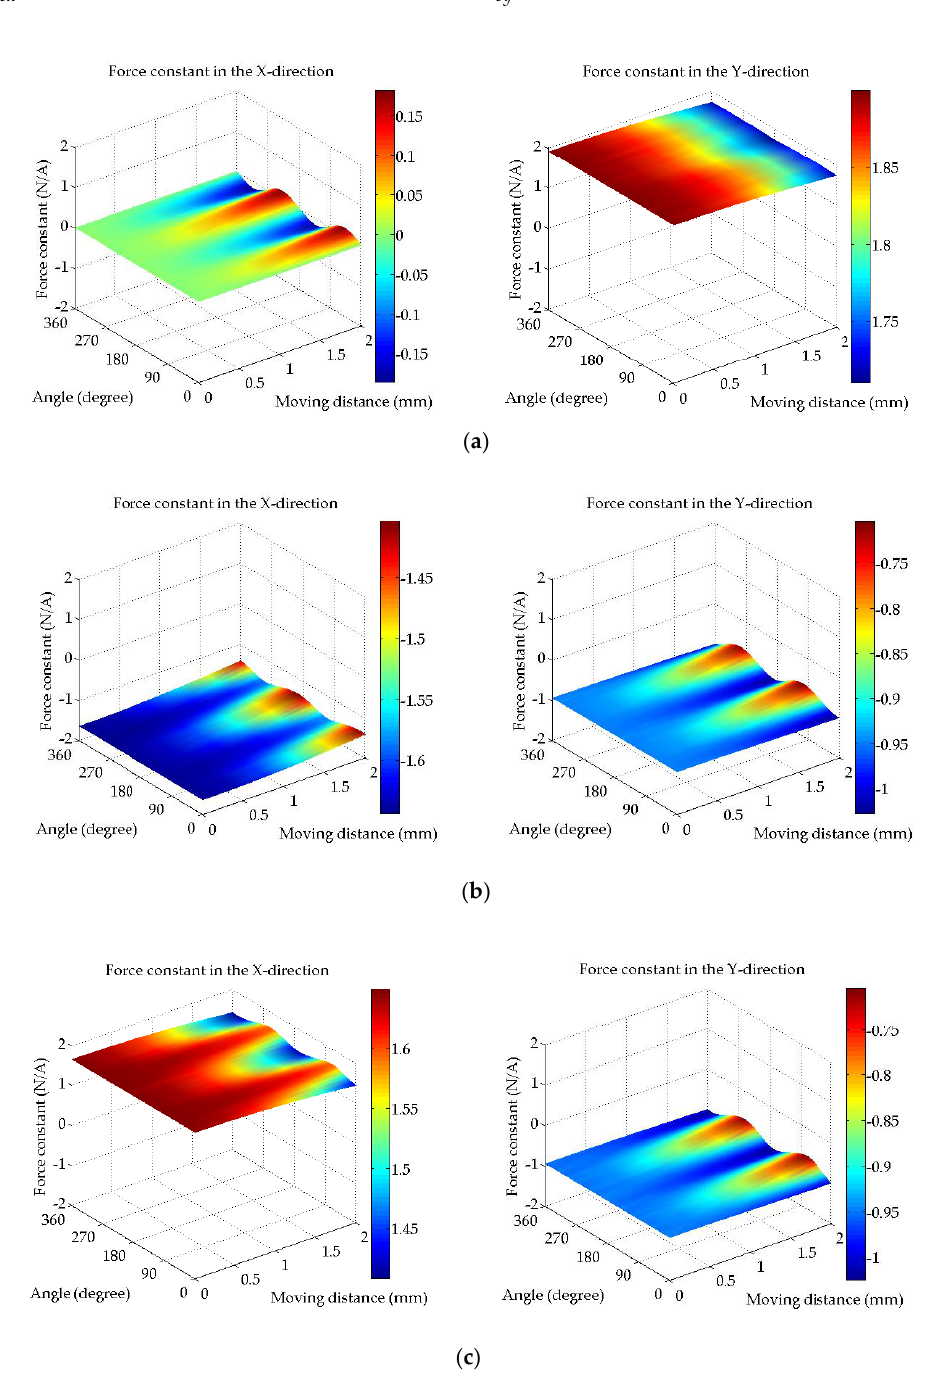
Figure 5. FEA results of force constant ( a ) U-phase, ( b ) V-phase, and ( c ) W-phase.